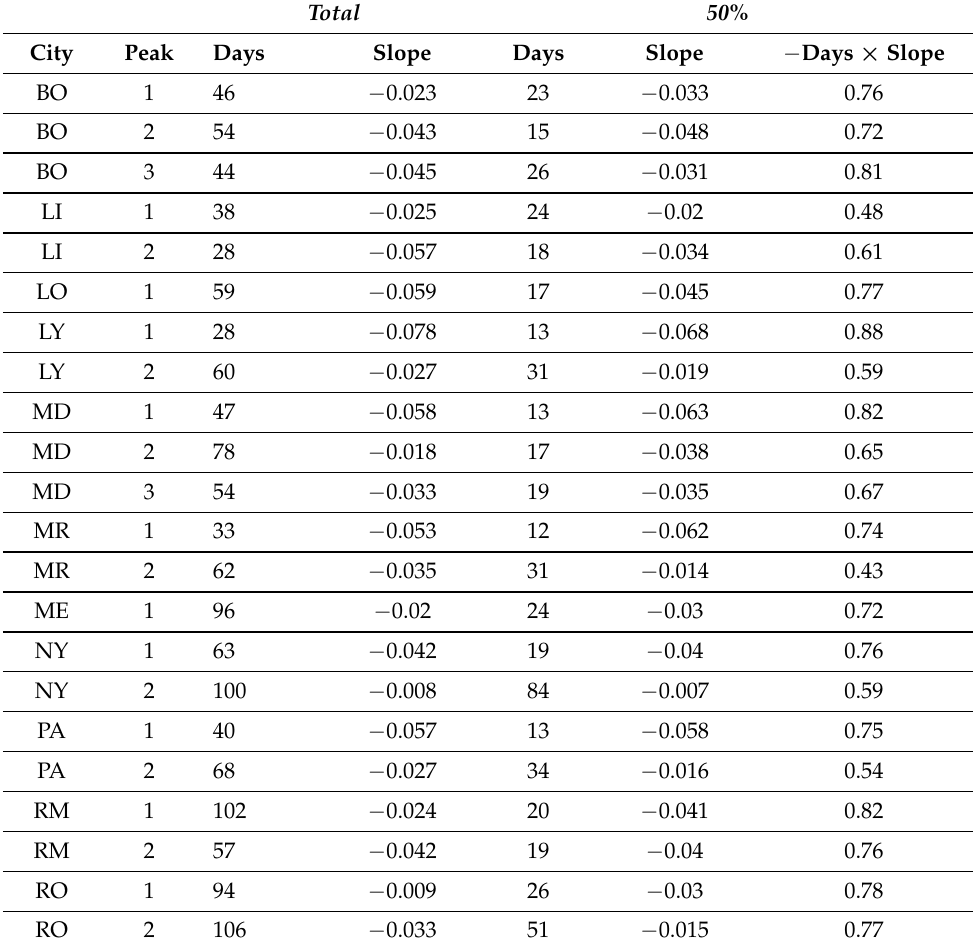
Table 7. Downward slopes for total and 50 %